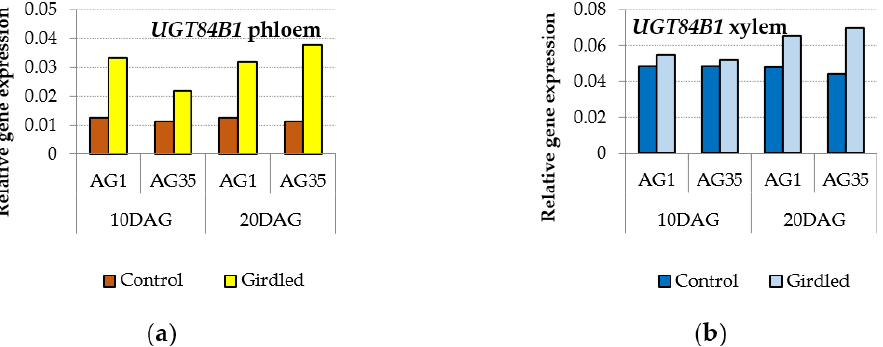
Figure 12. Relative gene expression of UGT84B1 gene in the phloem ( a ) and xylem ( b ) of control and girdled trees.